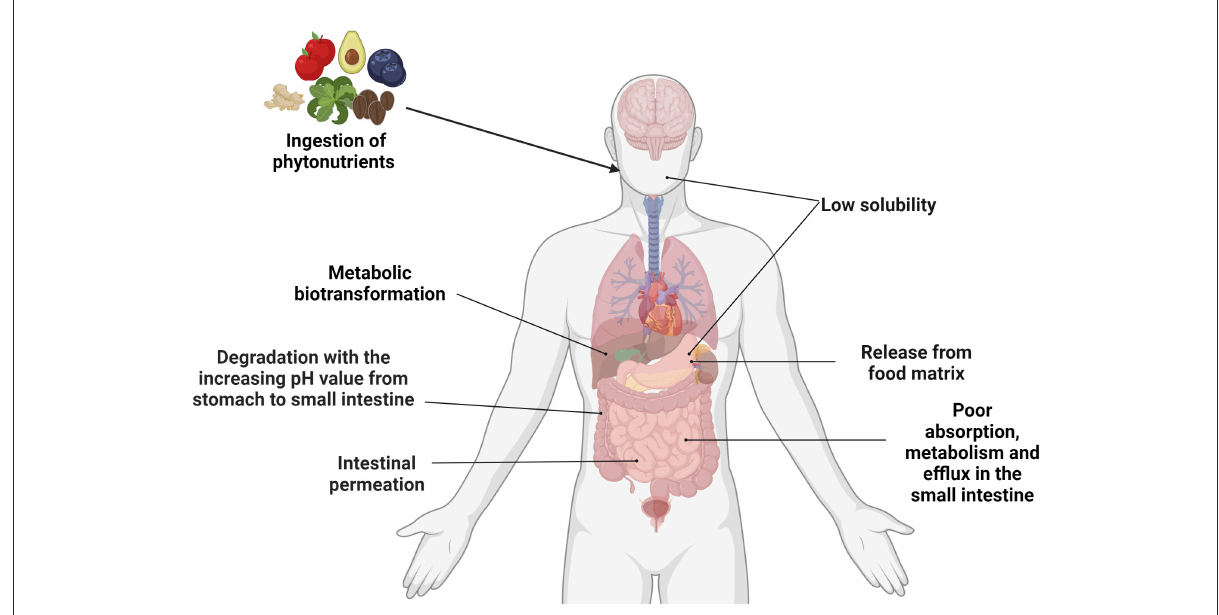
FIGURE1 Summary of the factors affecting the bioavailability of phytonutrients. Created with